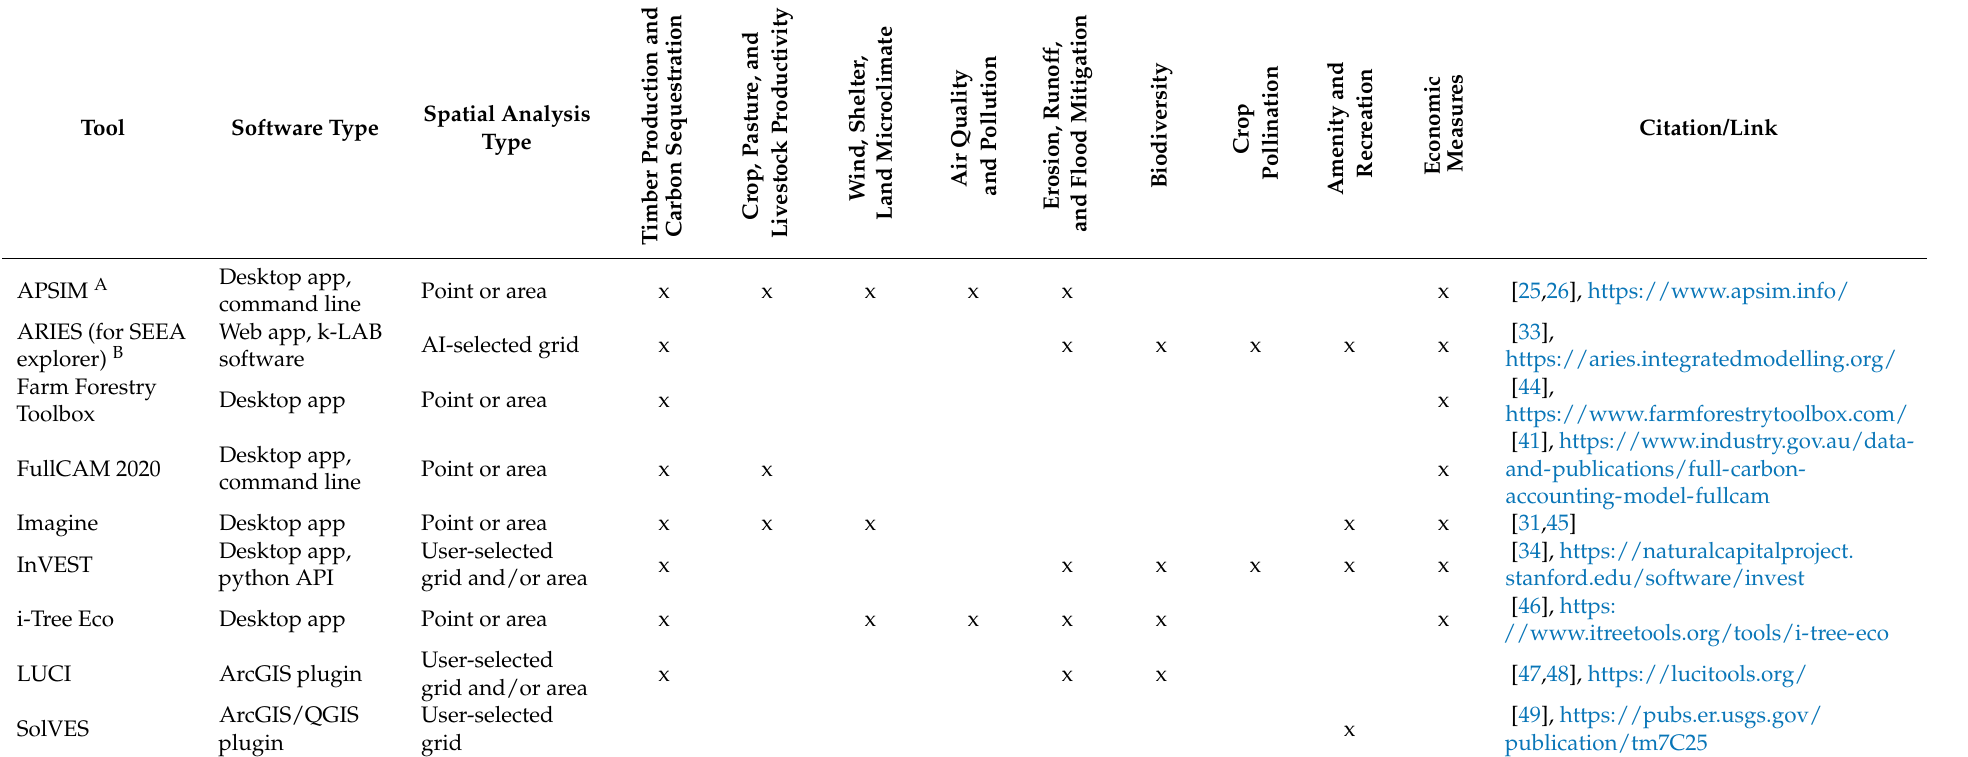
Table 1. Summary of shortlisted tools that can quantify the potential natural capital benefits of